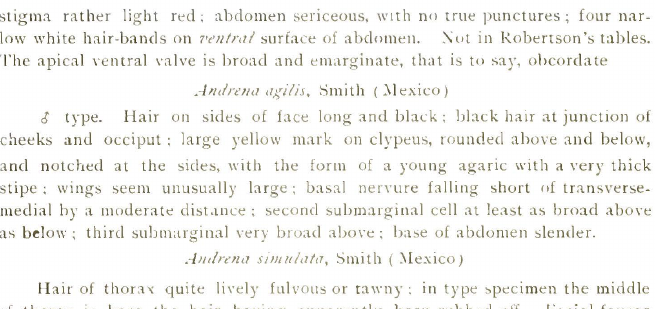
stigm:l r:lther light red ; abdomen sericeous, w1th no true punctures; four nar low white h:lir-bands on 7•oilral surface of :lbdomen. :\ut in Robertson's tables. The :lpical Yentral \':llve is broad and emarginate, that is to s:ly, ohcordate .-lndrt'll<l agilis, Smith ( ~1 exico) 6 type. Hair on sides of face long :lnd black; black hair at junction of cheeks and occiput ; large yellow mark on clypeus, rounded above and below, and notched at the sides, with the form of a young agaric with a very thick stipe ; wings seem unusually large; basal nervure falling short of transverse medial by a moderate clist.wce; second submarginal cell at least as broad above as below; third submarginal very broad abo\·e; base of abdomen slender. .-lndrc·na simul<lla, Smith ( :\lexico) Hair of thorax quite lively fnlvous or tawny: in type ~pecimen the middle of thorax is bare, the hair ha\·ing apparently been rubbed off. Facial fove:le deep, pubescent, brown seen from above, h:lving the form ot a somewhat oblique b:lnd of no gre:lt breadth, its upper end close to the outer ocellus, its lower close to the eye, at about the level of the antennae: thorax and abdomen shining, abdomen broad ; tegube clear amber: tirst recurrent nernue joining second sub marginal cell far beyond its middle